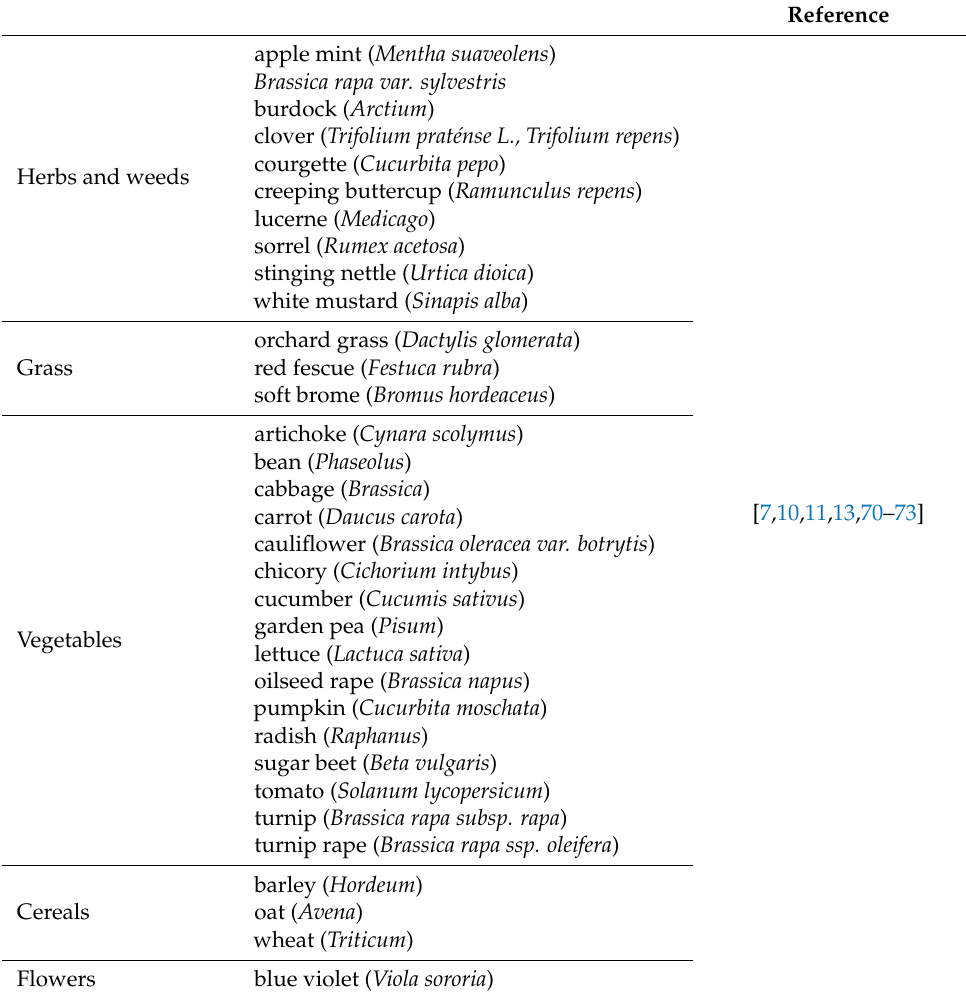
Table 4. Plant species preferred by edible